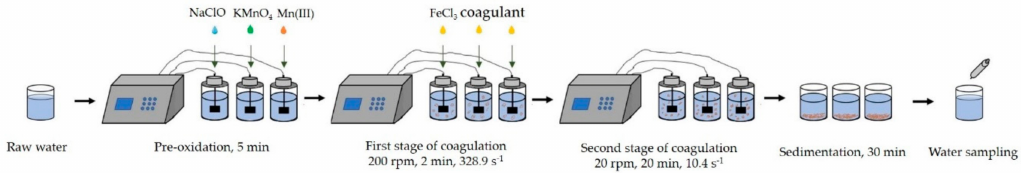
Figure 1. Experimental